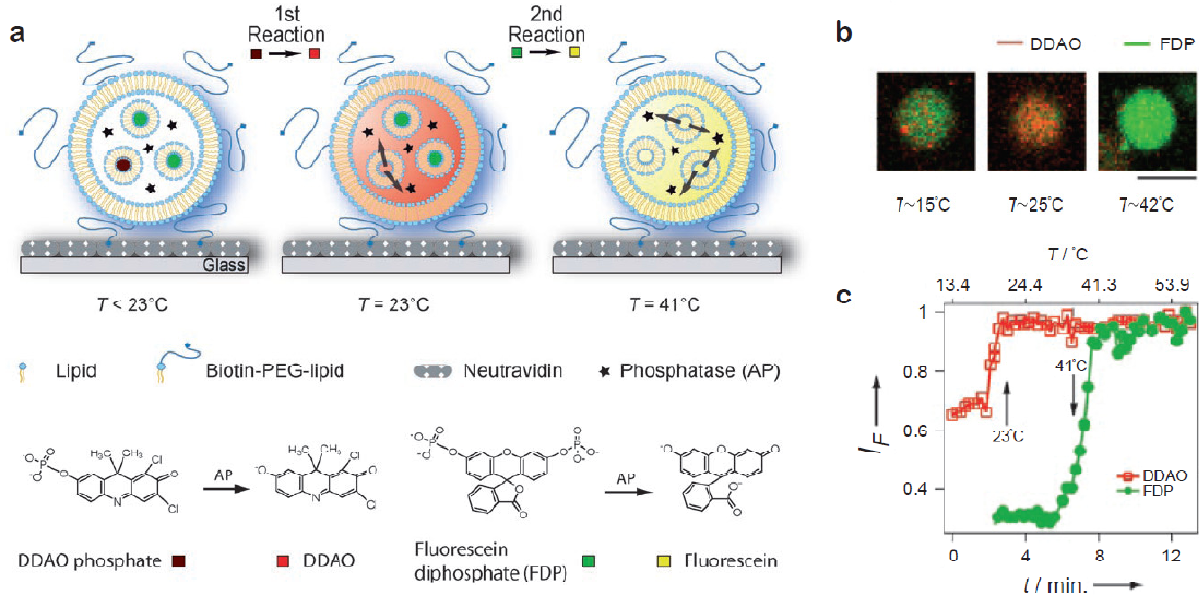
Figure 4. Self-assembled nanoscale fluidic device; consecutive enzymatic reactions triggered in single giant unilamellar vesicles. (a) A giant vesicle immobilised on a neutravidin-coated glass coverslip. Alkaline phosphatase (stars) was incorporated in the giant vesicle together with two different sets of small unilamellar vesicles (SUVs) each loaded with a different non-fluorescent substrate for the enzyme. One set of SUVs (T ≈ 23 °C) contained dichlorodimethylacridinone (DDAO) phosphate (dark red) and the t second SUV population (T ≈ 41 °C) carried fluorescein diphosphate (FDP, dark green). An t increase of temperature triggered the release of the substrates in two consecutive steps at the corresponding phase transition temperatures. After release from the SUVs, the substrates were confined in the lumen of the giant vesicle where they were processed to their respective fluorescent products by the enzyme. (b) Fluorescence micrographs of the process depicted in a. Bar: 10 µm. (c) Fluorescence intensity traces demonstrating sequential release of substrates and their conversion to fluorescent products in a single giant vesicle during a temperature ramp. Figure adapted from [32] (Copyright